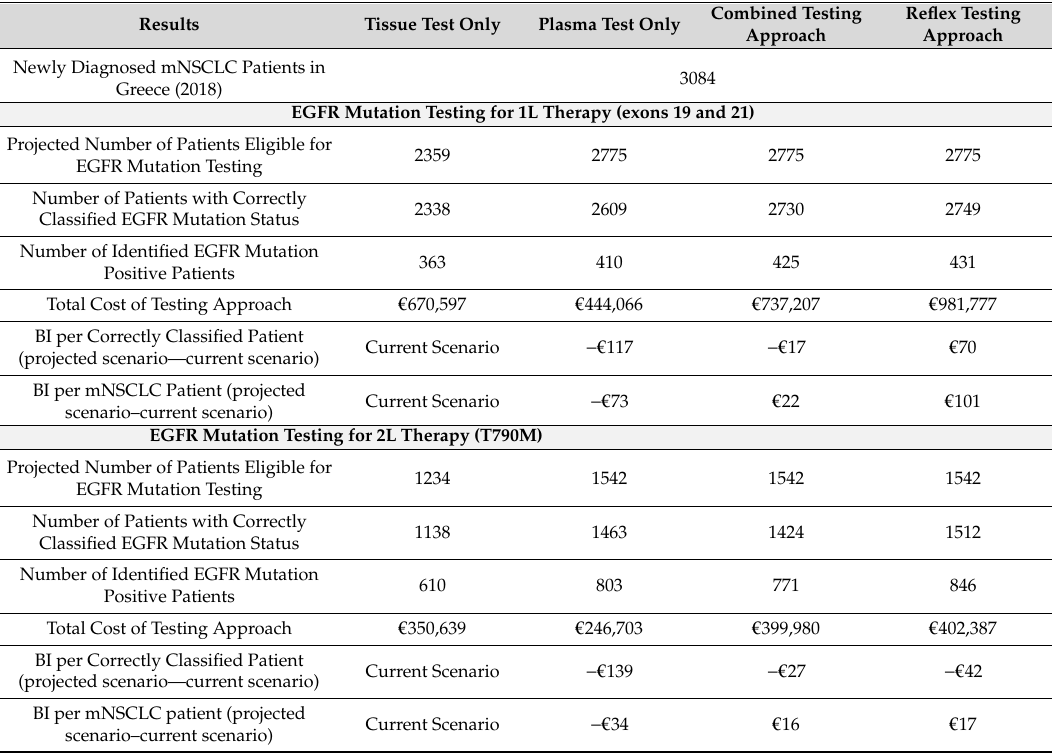
Table 4. Results of Base-Case